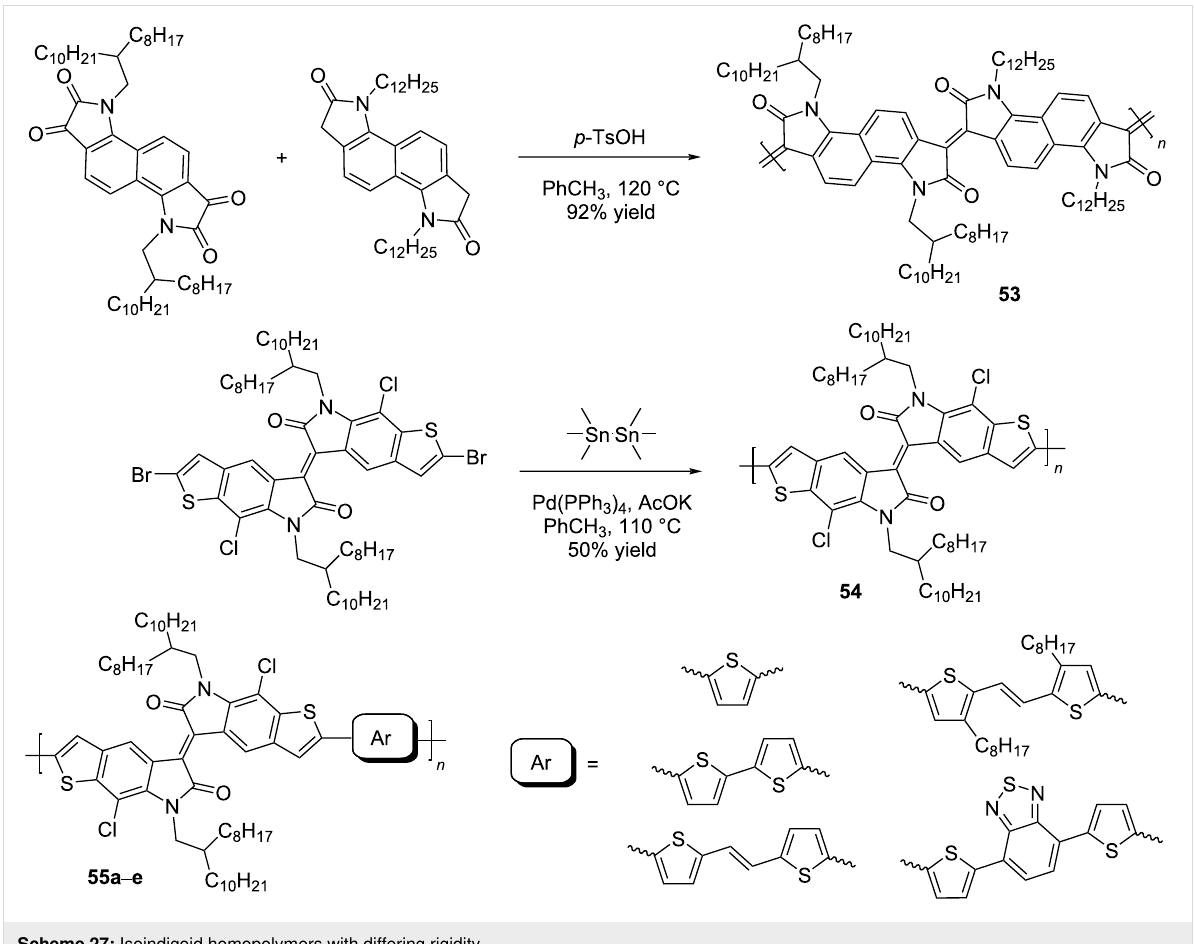
Scheme 27: Isoindigoid homopolymers with differing